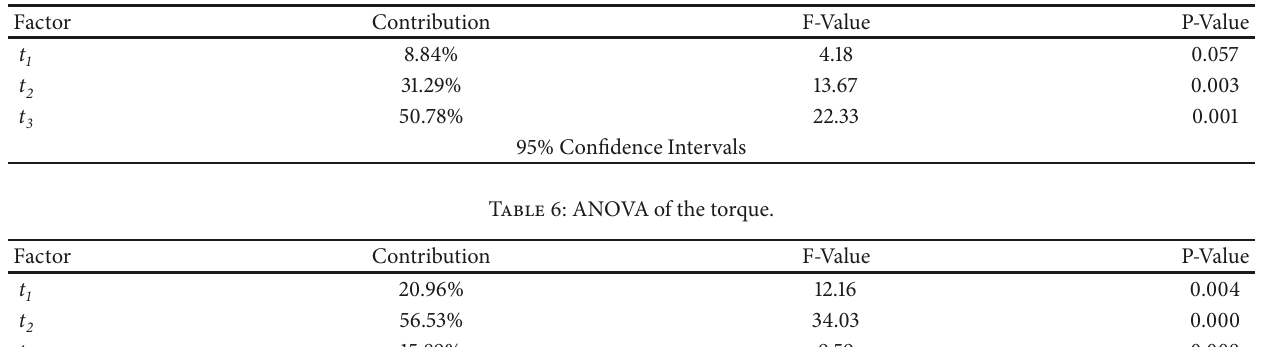
Table 5: ANOVA of the strain energy.